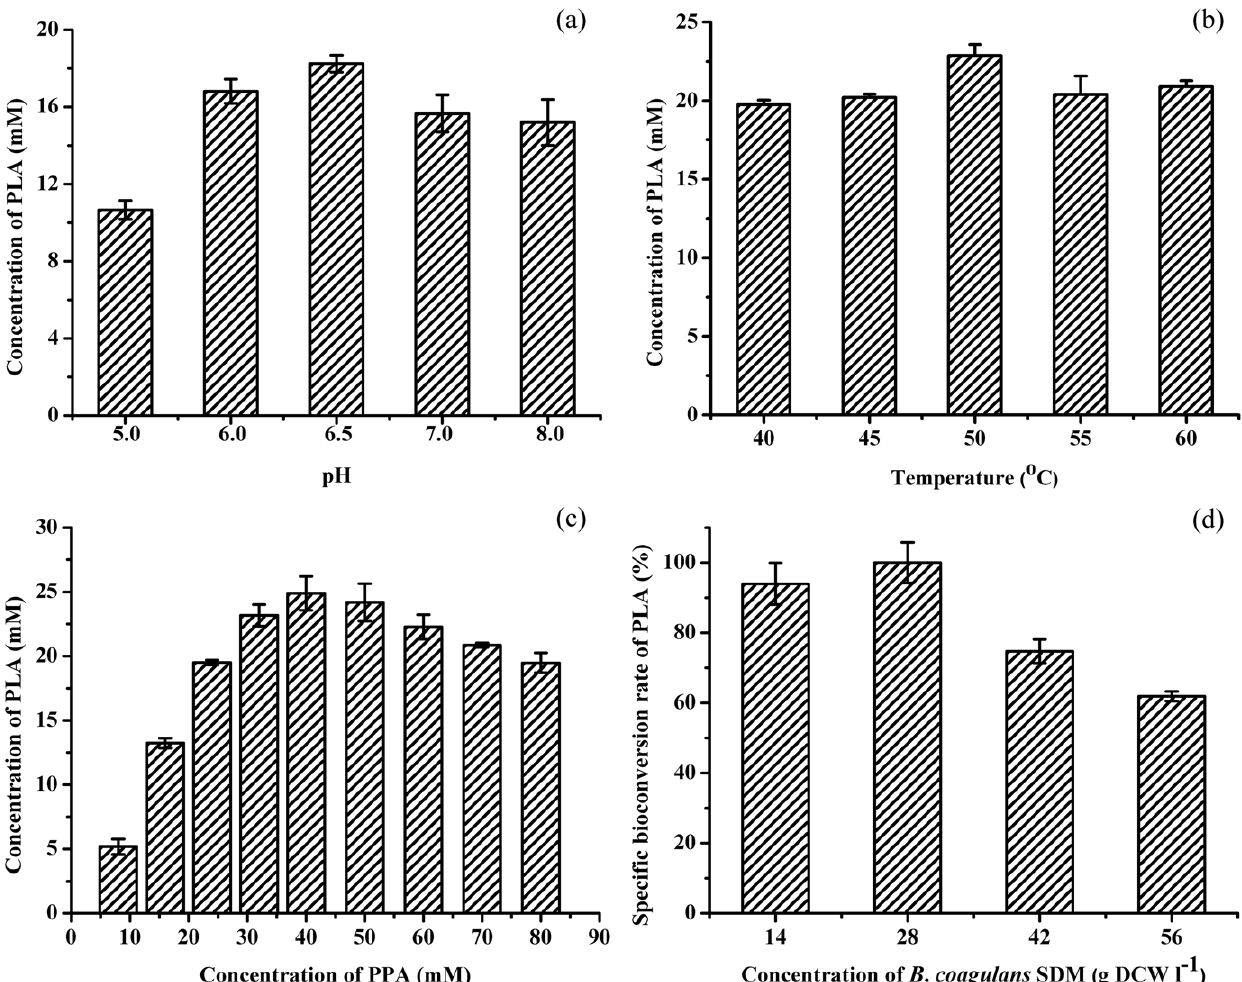
Figure 1. Optimization of bioconversion conditions. (a) Effect of pH on PLA production. (b) Effect of temperature on PLA production. (c) Effect of PPA concentration on PLA production. (d) Effect of biomass concentration on the specific bioconversion rate of PLA.